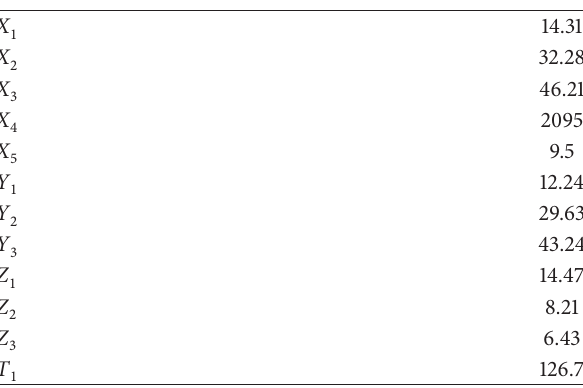
Table 11: Properties of the reference mix.